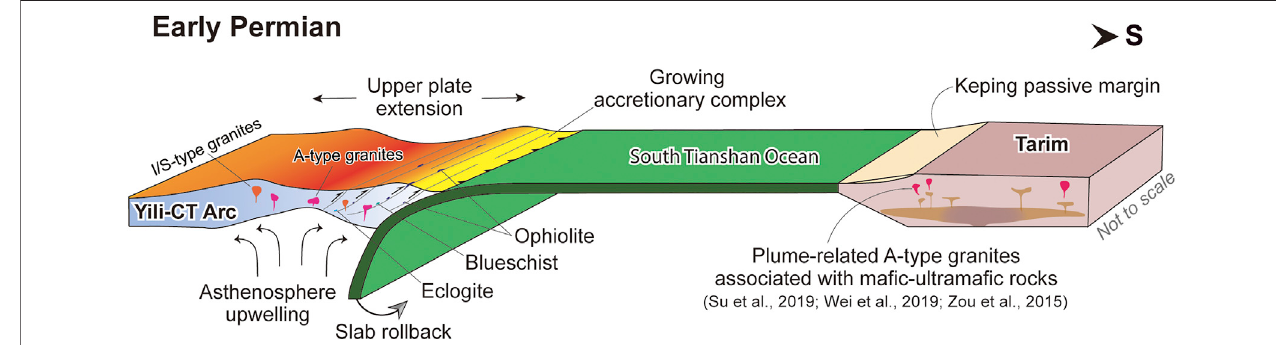
FIGURE 14 | Schematic model illustrating the tectonic relations that were responsible for the Early Permian A-type granitoids in the South Tianshan. In the Early Permian,upperplateextensionwasprobablyrelatedtosouthwardslabrollbackthatinducedupwellingofasthenosphericmantle,whichledtolarge-scalecrustalmelting that gave rise to the broad granitic arc in the southern active margin of the Yili-Central Tianshan. Formation of the A-type granitoids was facilitated by the high heat gradient beneath the extensional upper plate.